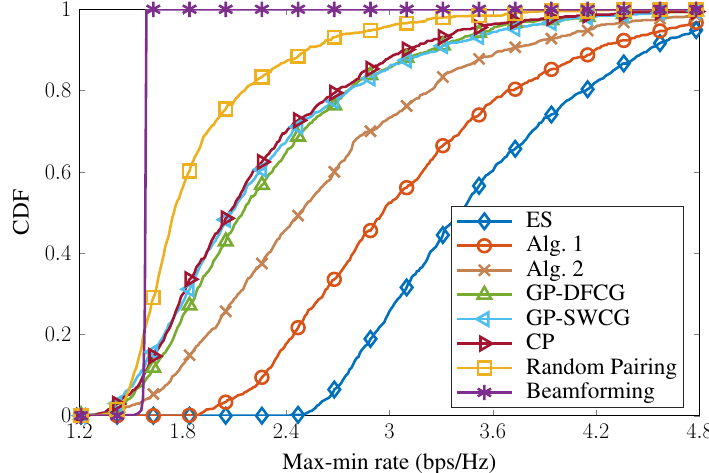
Figure 2. Cumulative distribution function of max-min